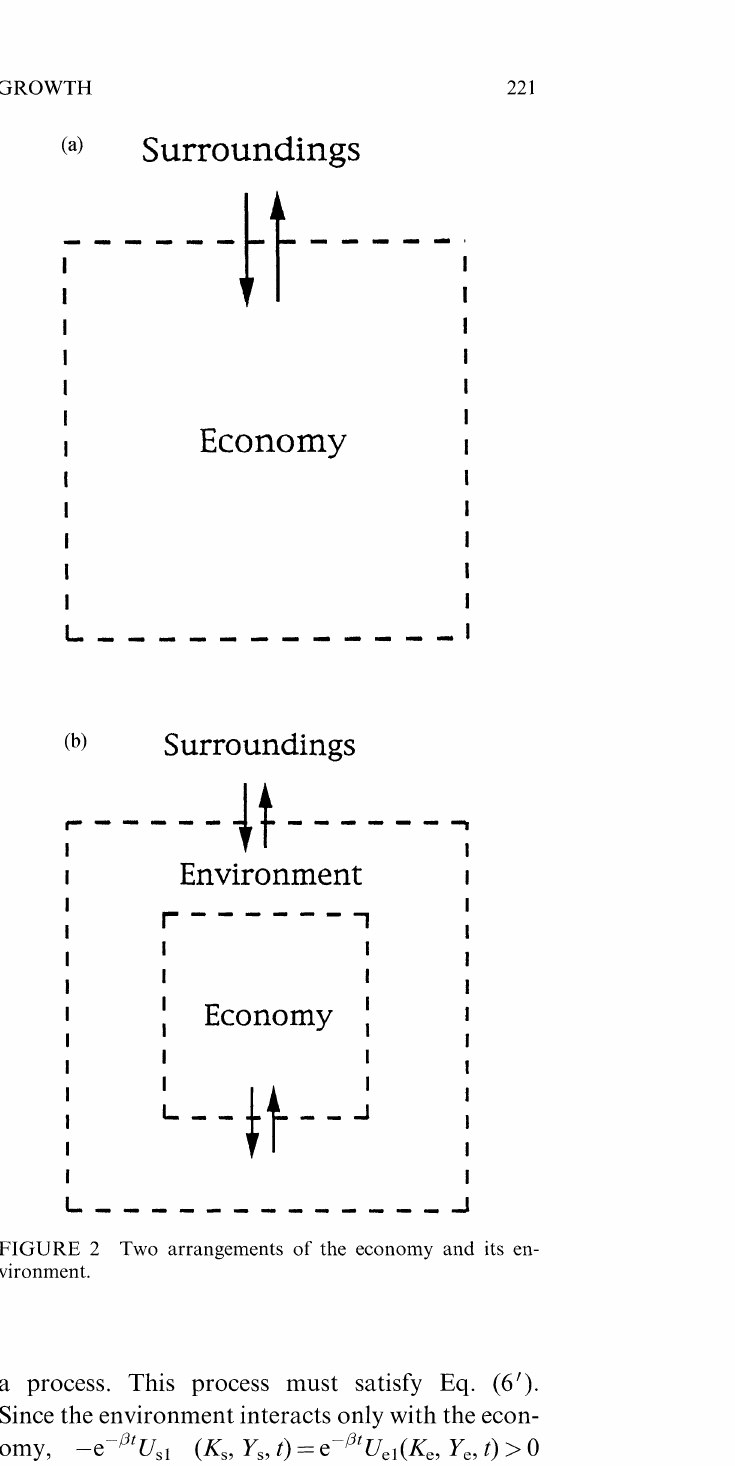
FIGURE 2 Two arrangements of the economy and its en-